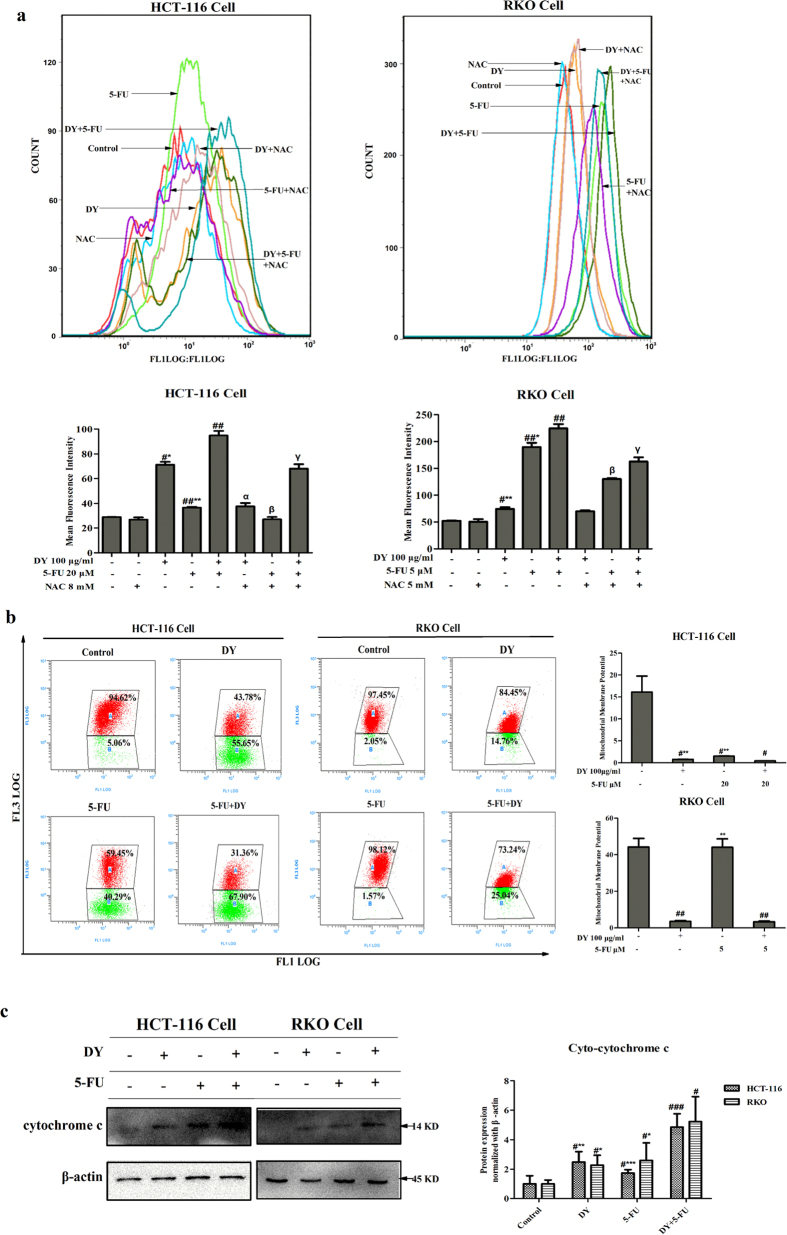
DY and 5-FU synergistically triggered the generation of ROS and disruption of MMP in CRC cells.(a) Cells were pre-treated with or without NAC, followed by DY and/or 5-FU. ROS levels of CRC cells loaded with DCFH-DA probes were evaluated by FCMS. (b) MMP levels were detected by JC-1 dye. JC-1 emits red fluorescence at high MMP levels by forming aggregate, while it emits green fluorescence as monomers at low MMP condition. The ratio of red/green fluorescence is used to indicate MMP levels. The distribution rates of J-aggregate and J-monomer in cells with DY/5-FU treatments are showed in the dot plots and cellular MMP levels are calculated in histograms. (c) After the indicated treatments, the cytosolic and mitochondrial fractions were isolated based on the manufacturer’s introduction of Cytochrome c Apoptosis Assay Kit. The expressions of cytosolic cytochrome c in two CRC cell lines were measured by western blotting analysis and normalized by β-actin, respectively. The levels of cytosolic cytochrome c were quantified in right histogram. The results are presented as mean ± SD (n = 3). #P < 0.05, ##P < 0.01, ###P < 0.001, vs control group. While *P < 0.05, **P < 0.01, ***P < 0.001, vs (5-FU + DY) group. αP < 0.05, βP < 0.05 and γP < 0.05, vs the corresponding group without NAC pre-treatment.